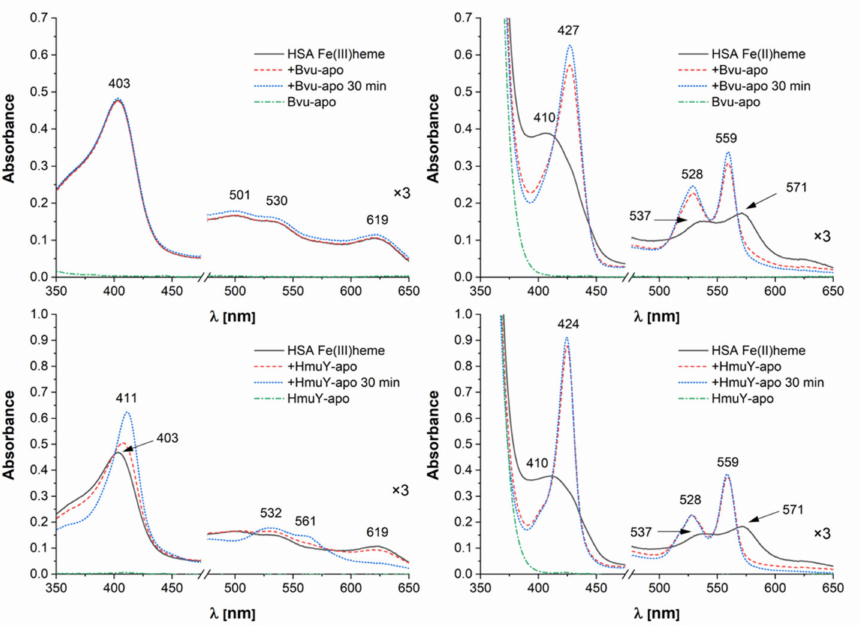
Figure 8. Heme sequestration from host hemoprotein. B. vulgatus Bvu or P. gingivalis HmuY pro- teins were incubated with an equimolar concentration of human serum albumin (HSA) under air (oxidizing) conditions (left panel) or reducing conditions formed by addition of sodium dithionite (right panel). Changes in absorption spectra analyzed by UV-visible spectroscopy are shown at indicated